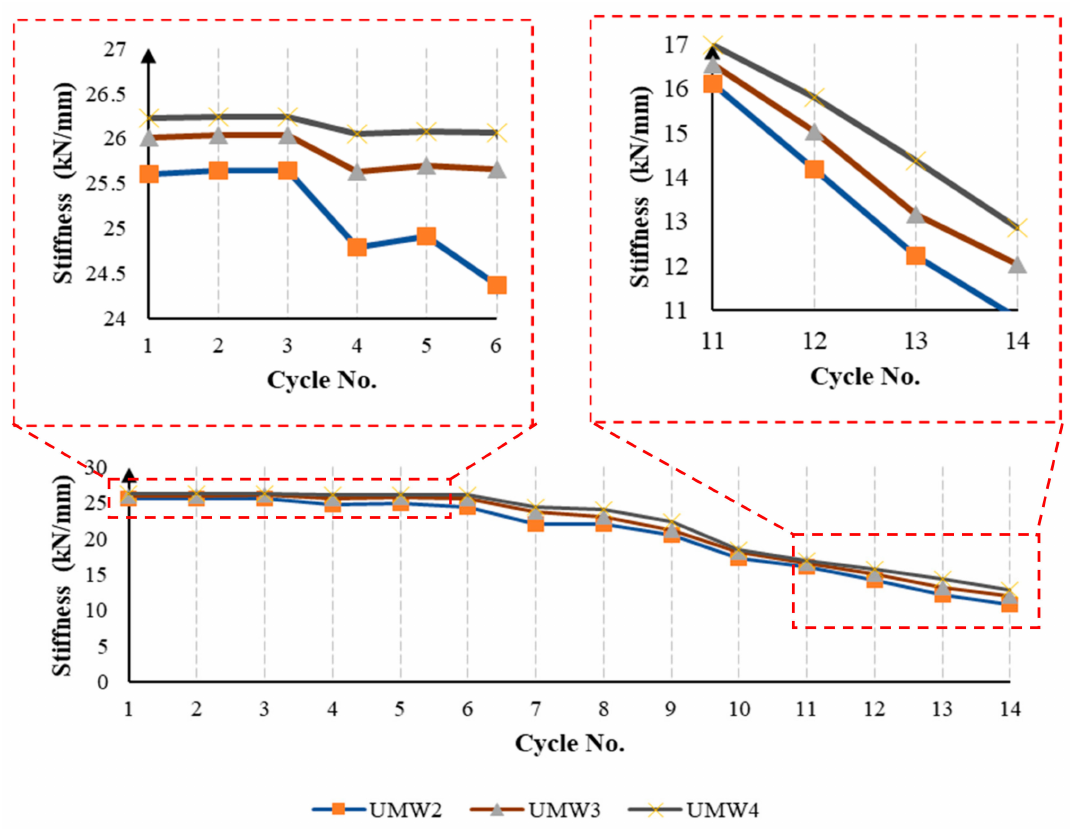
Figure 18. The stiffness reduction in the vertical-strip masonry walls during the